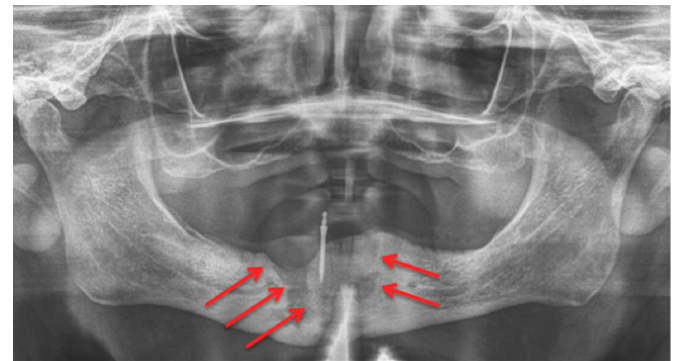
Figure 2. Panoramic radiograph: Patient: 77 years old, male, metastatic prostate cancer, ibandronic acid & later another antiresorptive drug: denosumab. Red arrows point to the necrotic area. Artefact due to thyroid shield. For the corresponding cone-beam computed tomography (CBCT) image, see Figure 4. AAMOS staging: stage 2.